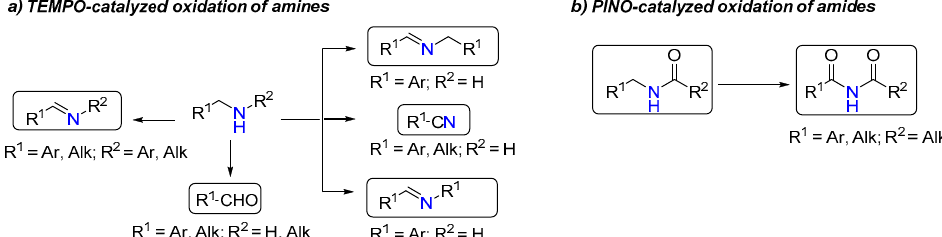
Figure 1. 2,2,6,6-Tetramethylpiperidine-1-oxyl (TEMPO) and phthalimide N -oxyl (PINO) involved oxidation of amine-containing substrates.